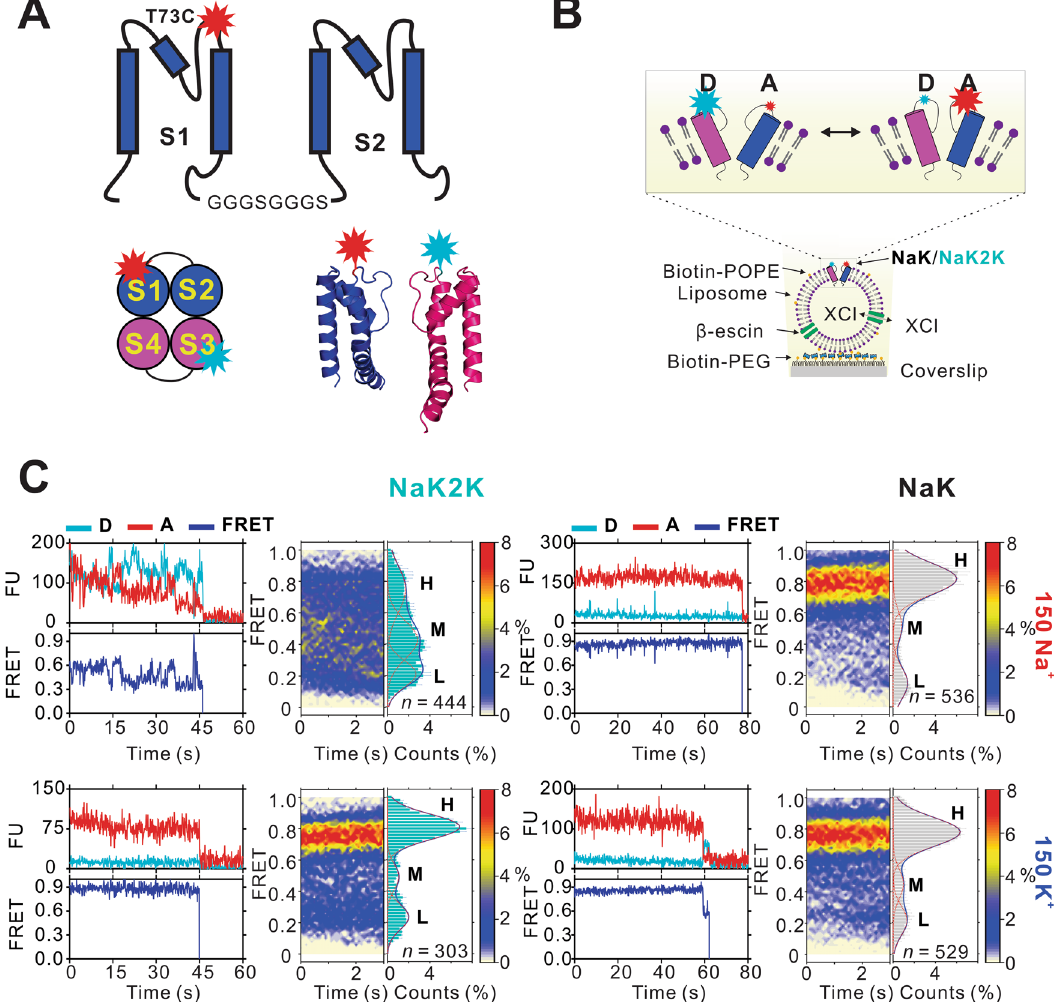
Fig.1|NaKandNaK2Kselectivity fi lterdynamics.A Strategyforintroducingtwo free cysteines within the tetrameric NaK channel. Organization of the tandem dimericconstructwherethecysteineisintroducedatpositionT73atthetoppartof the fi rst subunit (S1) TM2 domain (PBD 3E8H). Every linker contains two GGGS amino acid repeats. B Single-molecule FRET imaging of NaK proteins in liposomes labeled with Alexa Fluor 555/647 c2 maleimide pair. Proteoliposomes